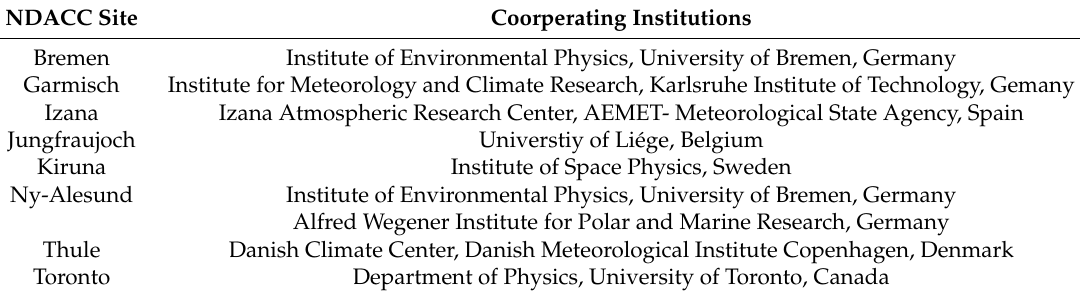
Table A1. Network for the Detection of Atmospheric Composition Change (NDACC) sites used in this publication and the coorperating